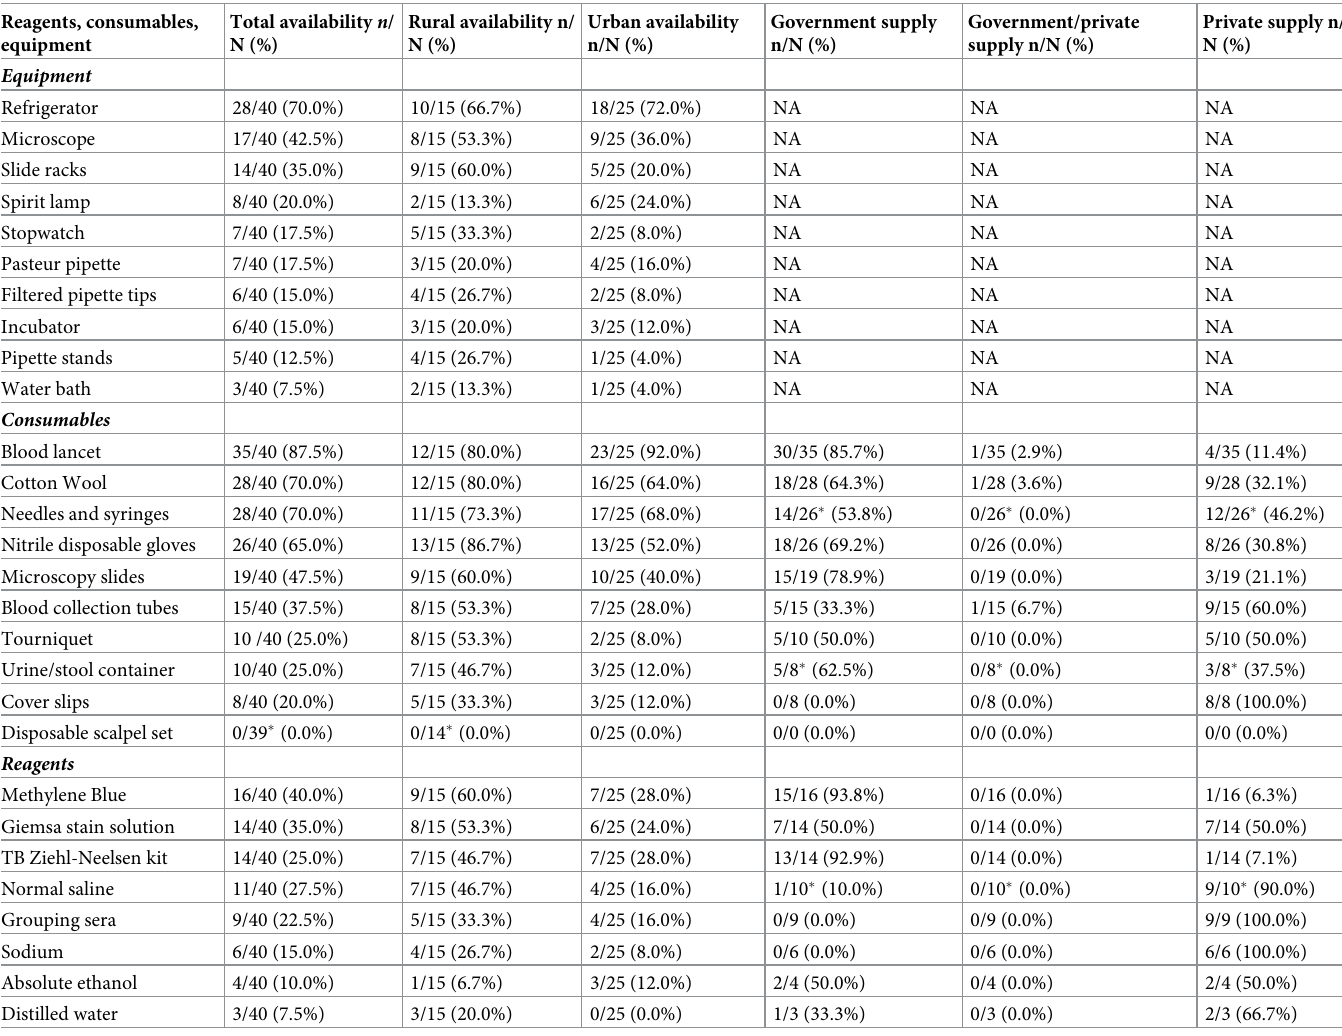
Table 1. Availability of equipment, consumables and reagents with the highest reported test availability (Malaria microscopy, TB sputum microscopy, biological specimen routine analysis (urine/stool microscopy), sickle cell disease, skin snip (oncho), and blood grouping). Reagents, consumables,